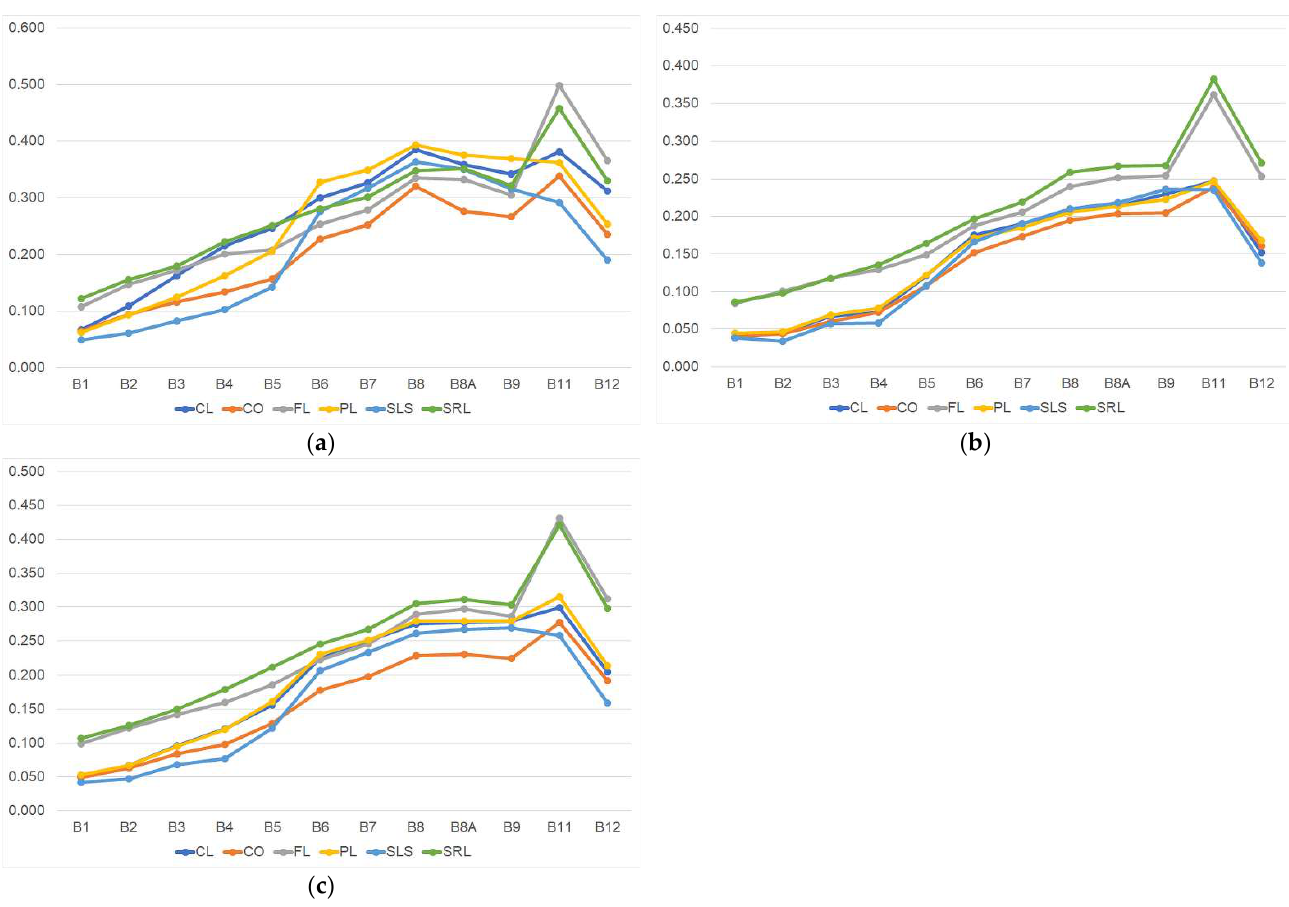
Figure 7. ( a ) MAX; ( b ) MIN; ( c ) average spectral signature values of each lithological unit.